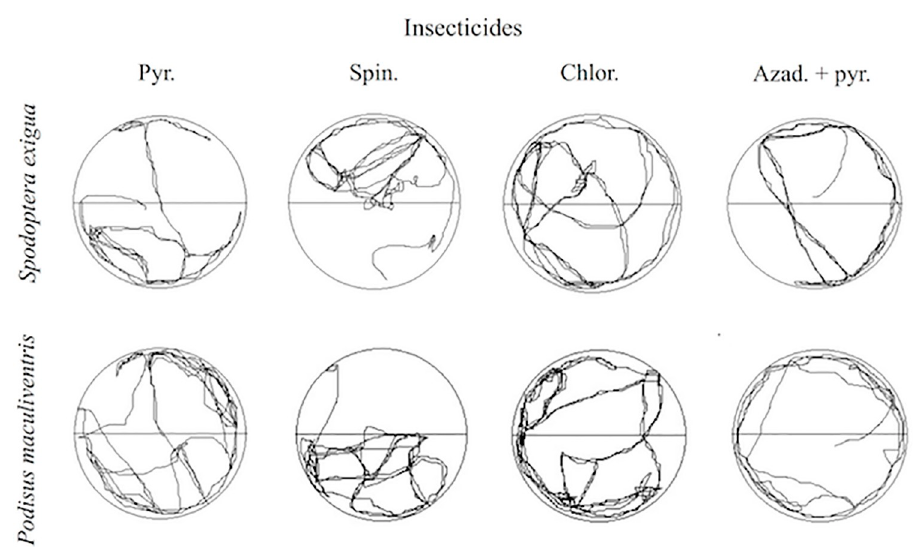
Fig 2. Tracks showing the movement of each 3 rd instar individual beet armyworm, Spodoptera exigua and spined soldier bug nymphs, Podisus maculiventris , for 10 minutes by Petri dishes lined with filter paper (9 cm diameter) with half impregnated with dry insecticide residues. Half lid of each Petri dish was